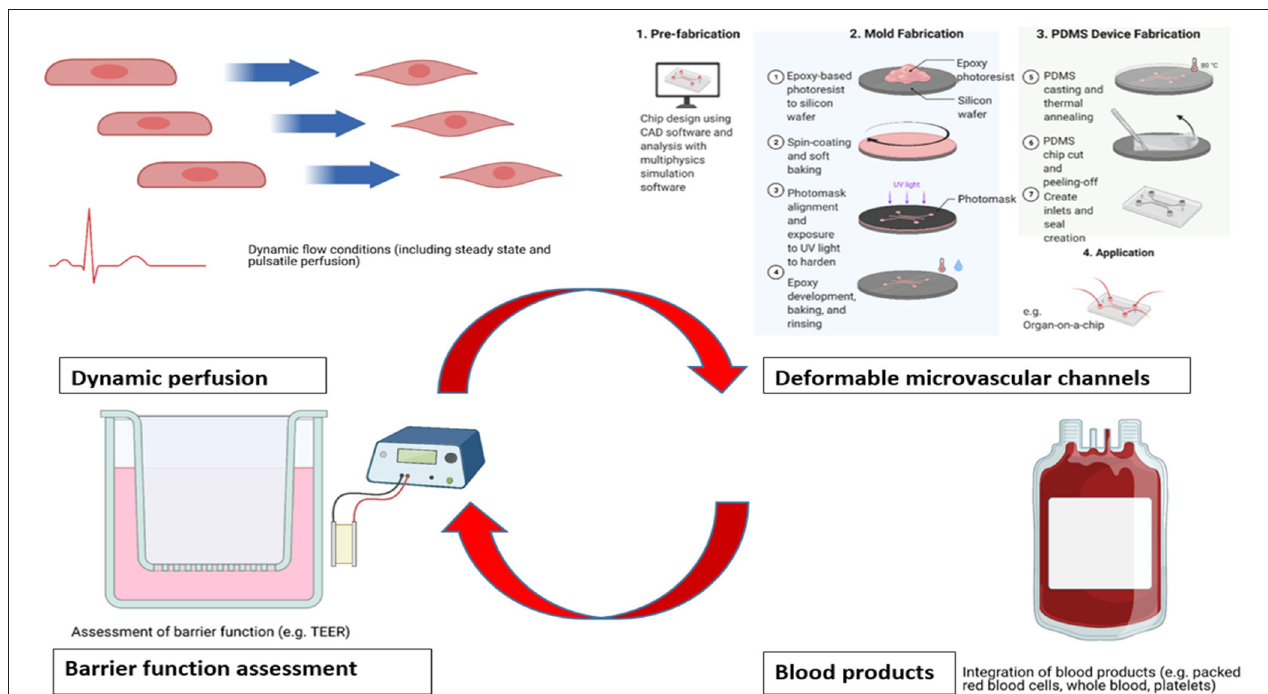
FIGURE 1 | Areas for potential enhancement for existing in vitro benchtop models studying glycocalyx pathophysiology. Acknowledgment: Biorender.com